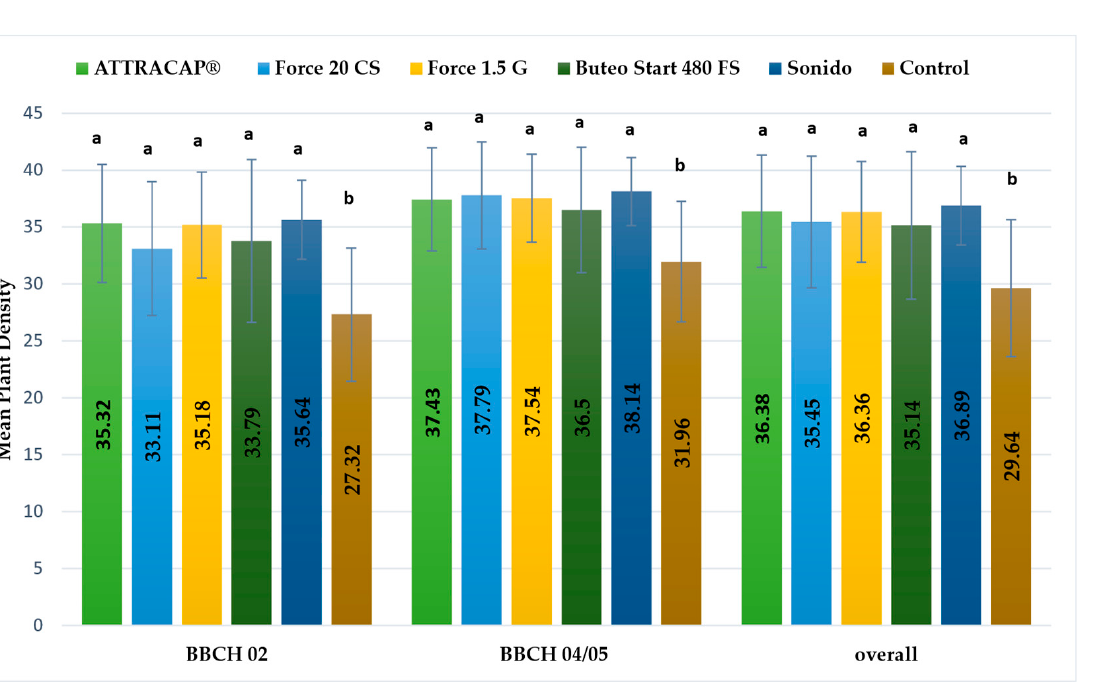
Figure 3. Plant density depending on the insecticidal treatment at RŠ Field 1 in 2021.